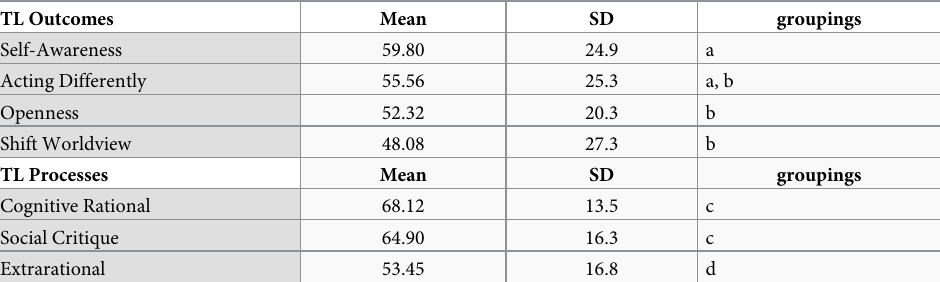
Table 2. Ranked means for TLS outcome scales and process domains.